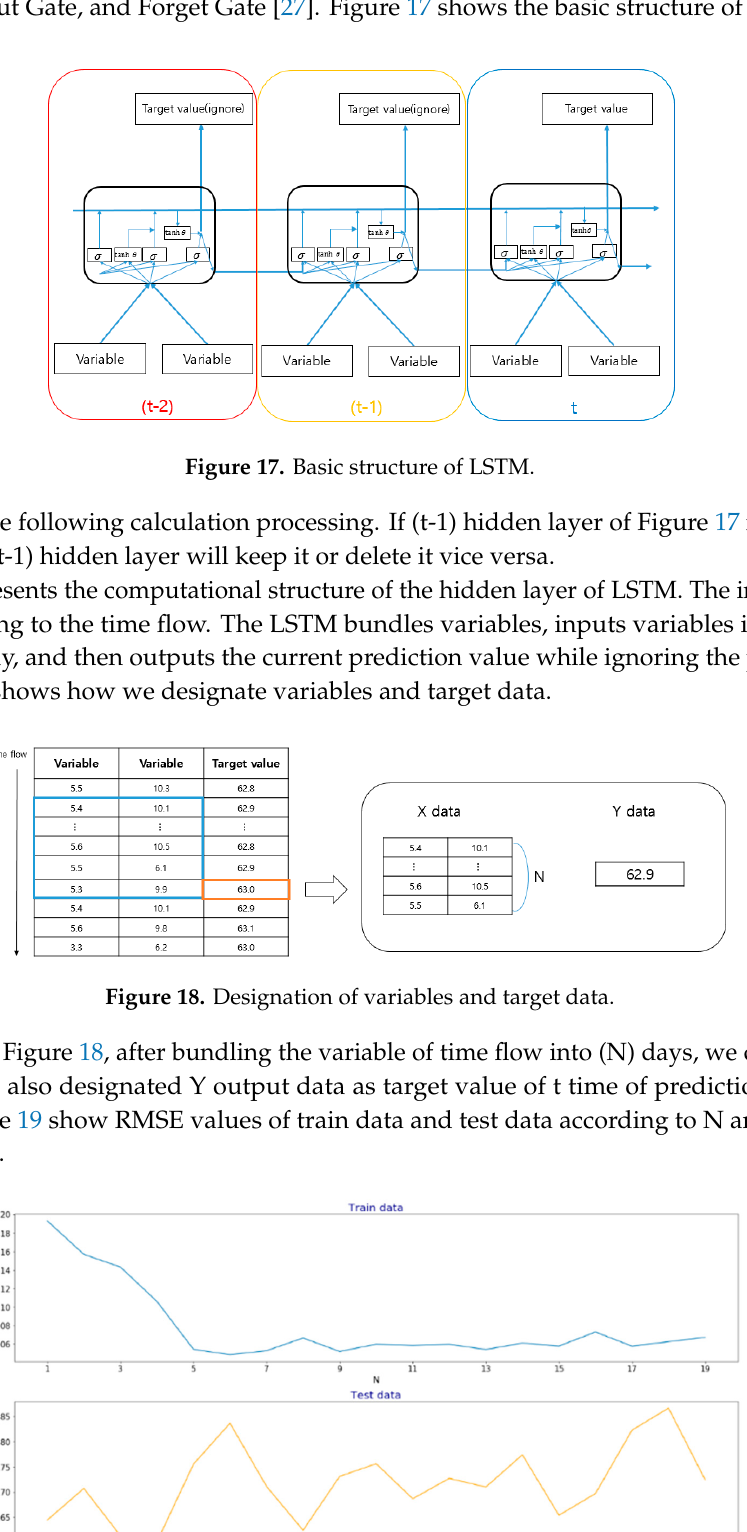
Figure 16. Configuration of MLP-based algorithm to predict the amount of EPT.